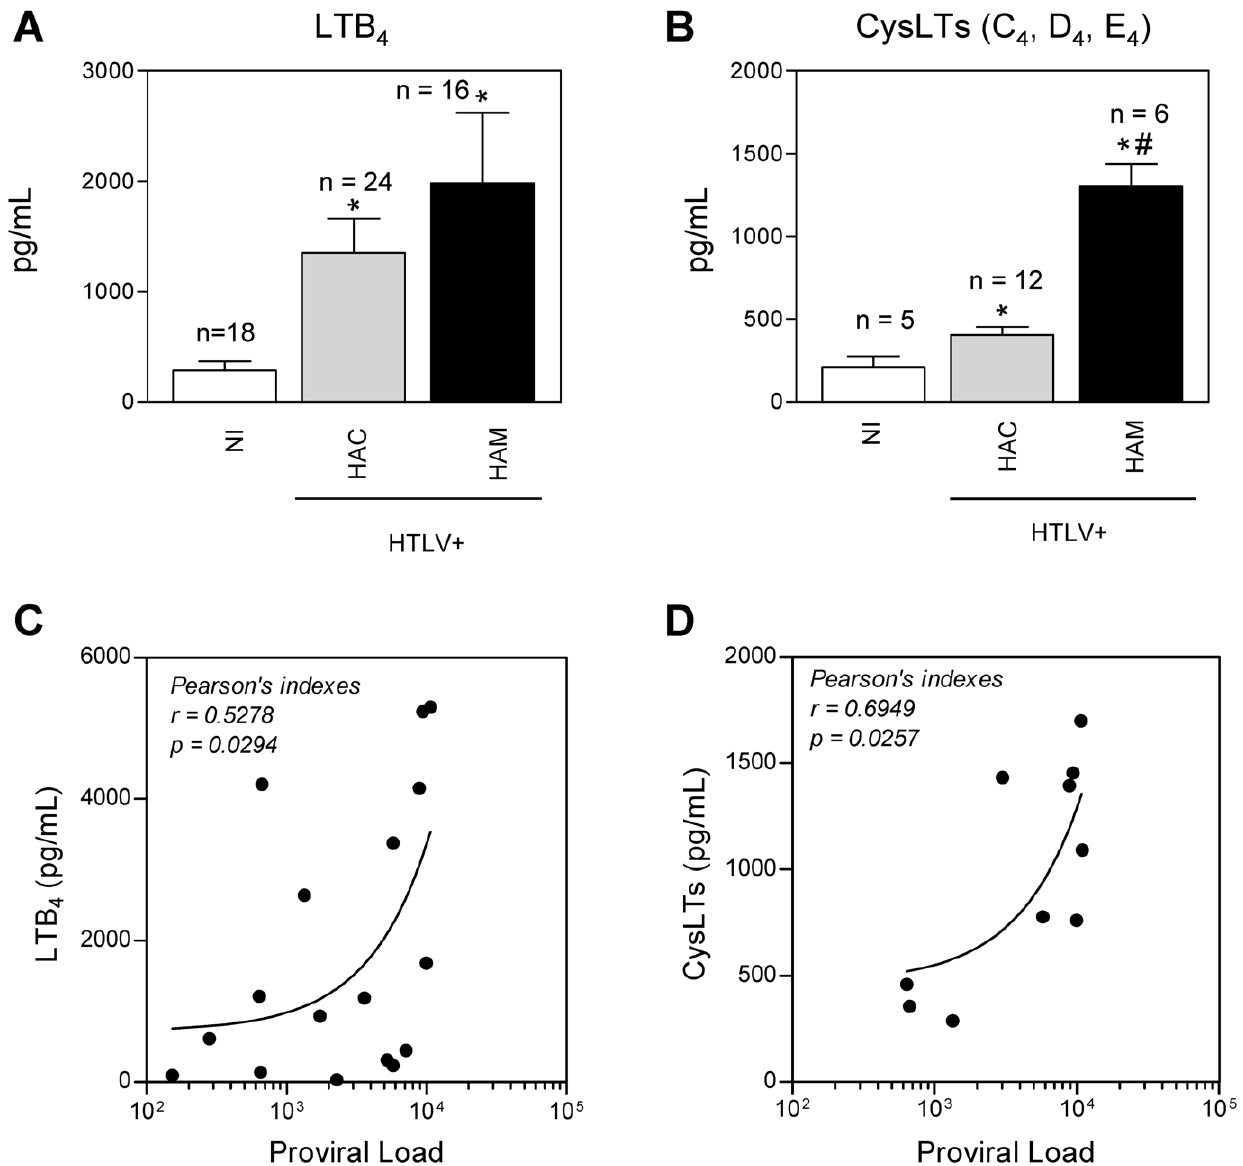
Figure 1. Leukotrienes are increased in the plasma of HTLV-1-infected subjects and correlate with the proviral load. LTB 4 (A) and CysLTs (B) were measured by EIA after sample purifications on Waters C18 Sep-Pak cartridges. Plasma from non-infected healthy donors (NI), HTLV-1 asymptomatic carriers (HAC) and HAM/TSP subjects (HAM) were used. (C, D) A correlation is shown between the plasma levels of LTB 4 (C), CysLTs (D) and the DNA proviral load in peripheral blood mononuclear cells of HTLV-1-infected individuals (HAC and HAM/TSP) using Pearson rank correlation test. The data are presented as means 6 SEM. * p , 0.05, compared with control; # p , 0.05, compared with HAC (one-way ANOVA). Statistically significant correlations at p , 0.05 are displayed in the graphs along with Pearson’s coefficient